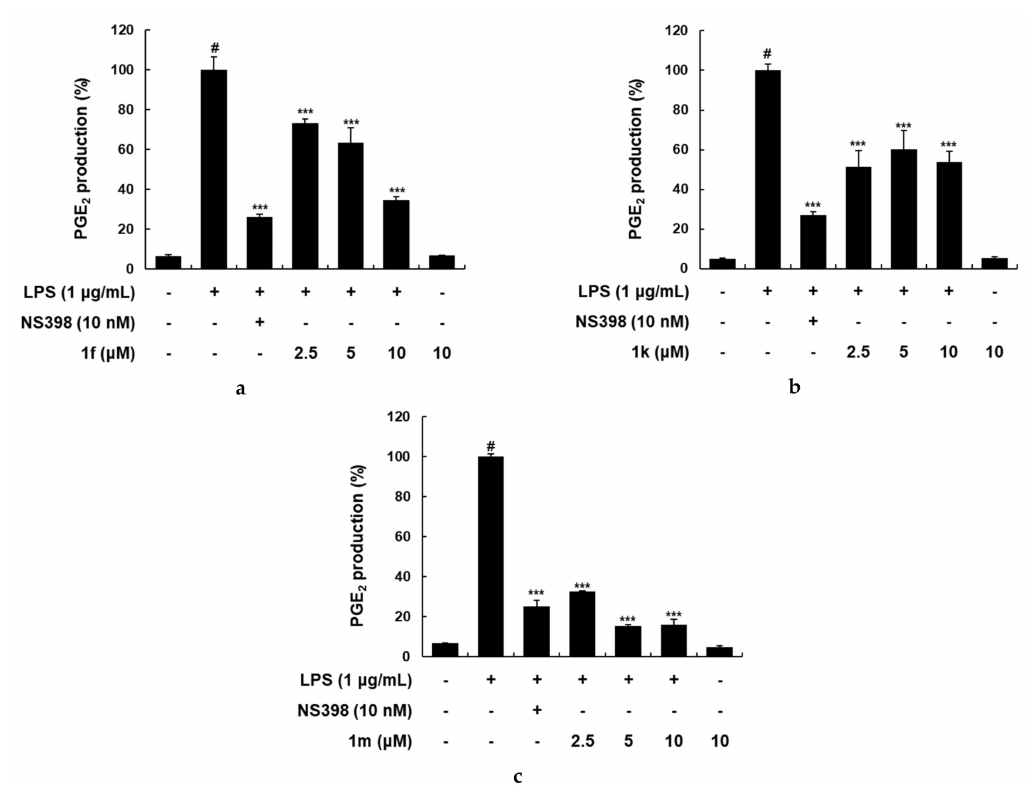
Figure 3. Effects of compounds 1f ( a ), 1k ( b ), and 1m ( c ), and NS398 on LPS-stimulated PGE 2 production in RAW 264.7 macrophages. # means significant difference from the negative control and *** means significant difference from the positive